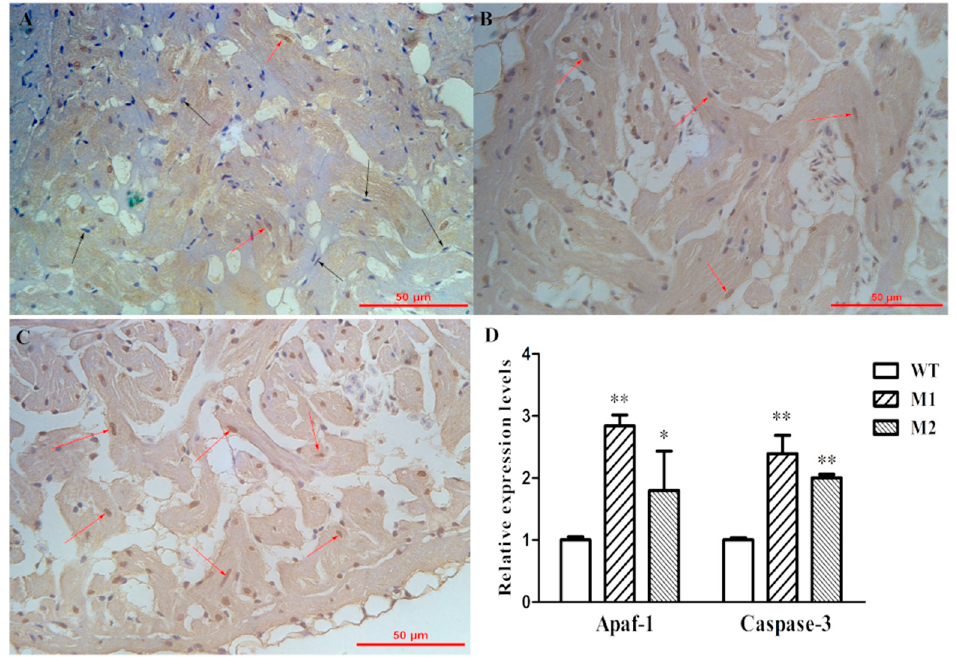
Figure 7. Increased apoptosis was observed in pr130 − / − . ( A – C ) Representative images of Tunel staining sections of adult heart tissue of WT ( A ), M1 ( B ), and M2 ( C ). Black arrows indicate normal cells ( blue ), red arrows indicate apoptosis cells ( brown ); ( D ) Expression levels of apoptosis-associated genes from adult heart tissues. Data represent the mean ± SD. The symbols * and ** in the bar chart represent significant differences ( p < 0.05 or p < 0.01).